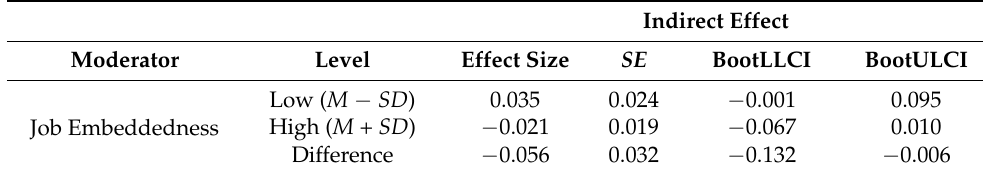
Table 4. Table of tests for mediating effects with moderation.